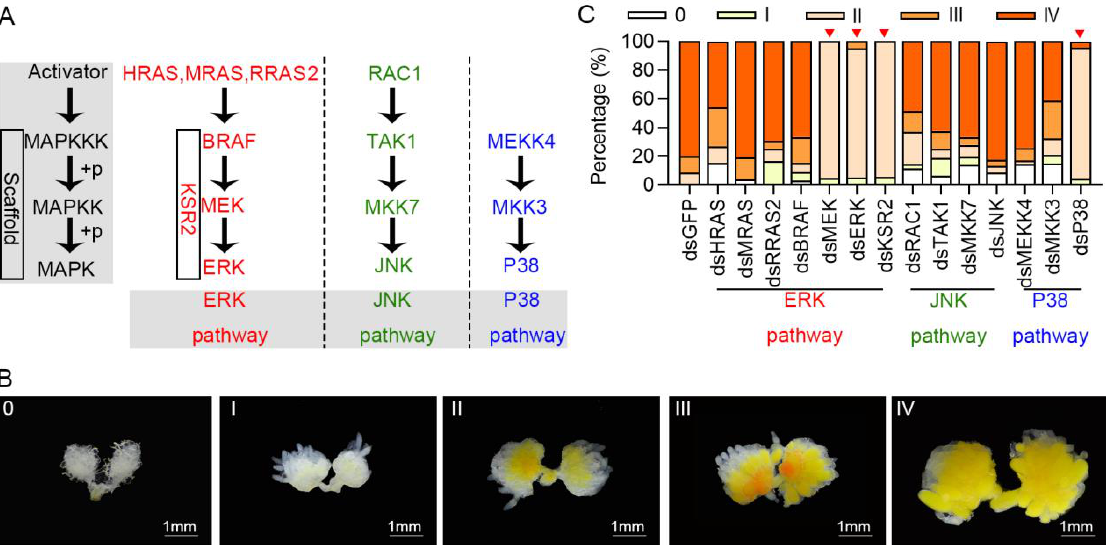
Figure 1. RNAi knockdown of candidate genes in the MAPK signaling pathway in female C. bowringi. ( A ) The pathway diagram shows 14 candidate genes from ERK, JNK, and P38 pathways in the MAPK signaling pathway. ( B ) Ovary phenotypes of C. bowringi at 0, I, II, III, and IV development grades. Grade 0, the ovary is white and transparent, and the ovariole presents silk thread shape; Grade I, the ovariole is obviously tubular, and the yolk deposition begins; Grade II, yolk gradually deposited and ovary gradually expanded; Grade III, a small amount of mature eggs have appeared, and there are no eggs in the lateral oviduct; Grade IV, the ovariole is full of mature eggs, and mature eggs can also be seen in the lateral oviduct. ( C ) The development grades of candidate genes knocked down at 4-day PE ( n = 23–37). Genes marked with red triangles significantly inhibited ovarian